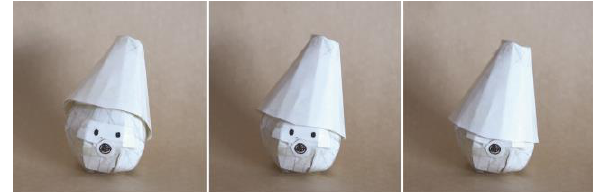
Figure 6 | First paper prototype. From left: active; calm; and scared.